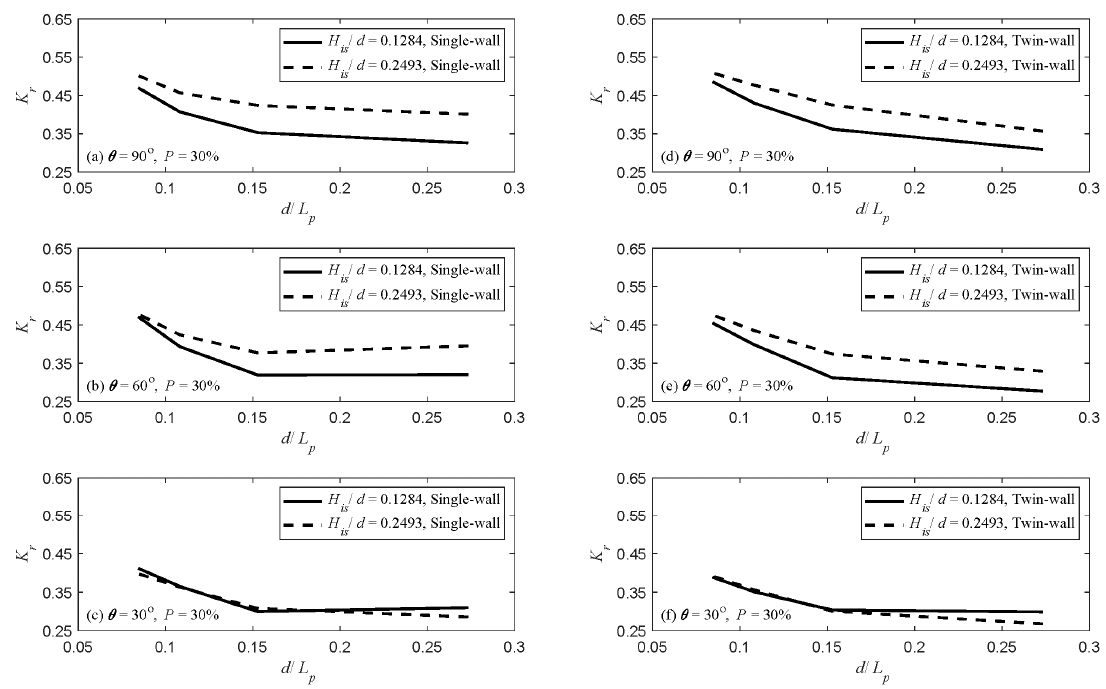
Figure 21. Effect of H is / d on K r for P = 30% and different wall slopes. Subfigures ( a ), ( b ), and ( c ) are for Figure 21. E ff ect of H is / d on K r for P = 30% and di ff erent wall slopes. Subfigures ( a ), ( b ), and ( c ) are for single-wall, and subfigures ( d ), ( e ), and ( f ) are for twin-wall. single-wall, and subfigures ( d ), ( e ), and ( f ) are for